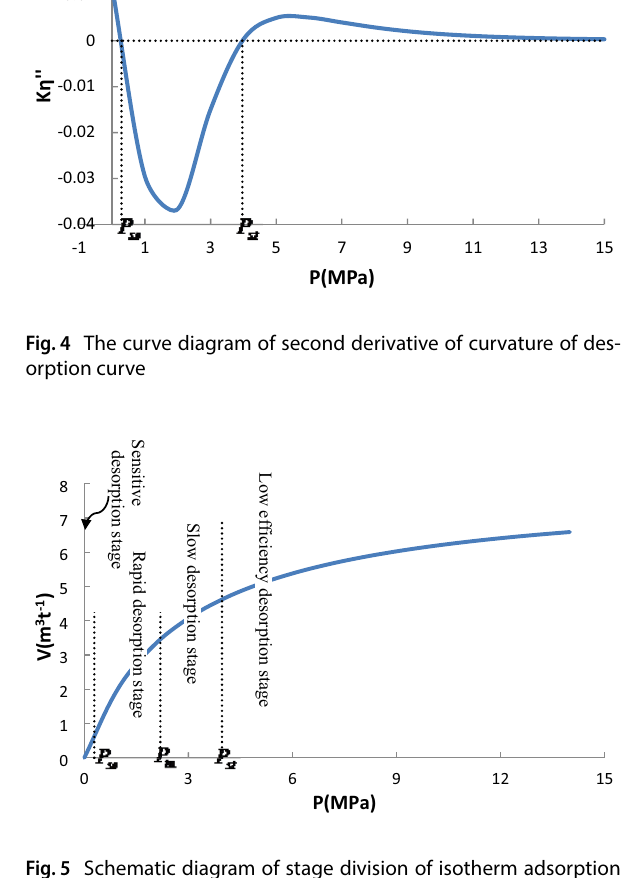
Fig. 5 Schematic diagram of stage division of isotherm adsorption curve